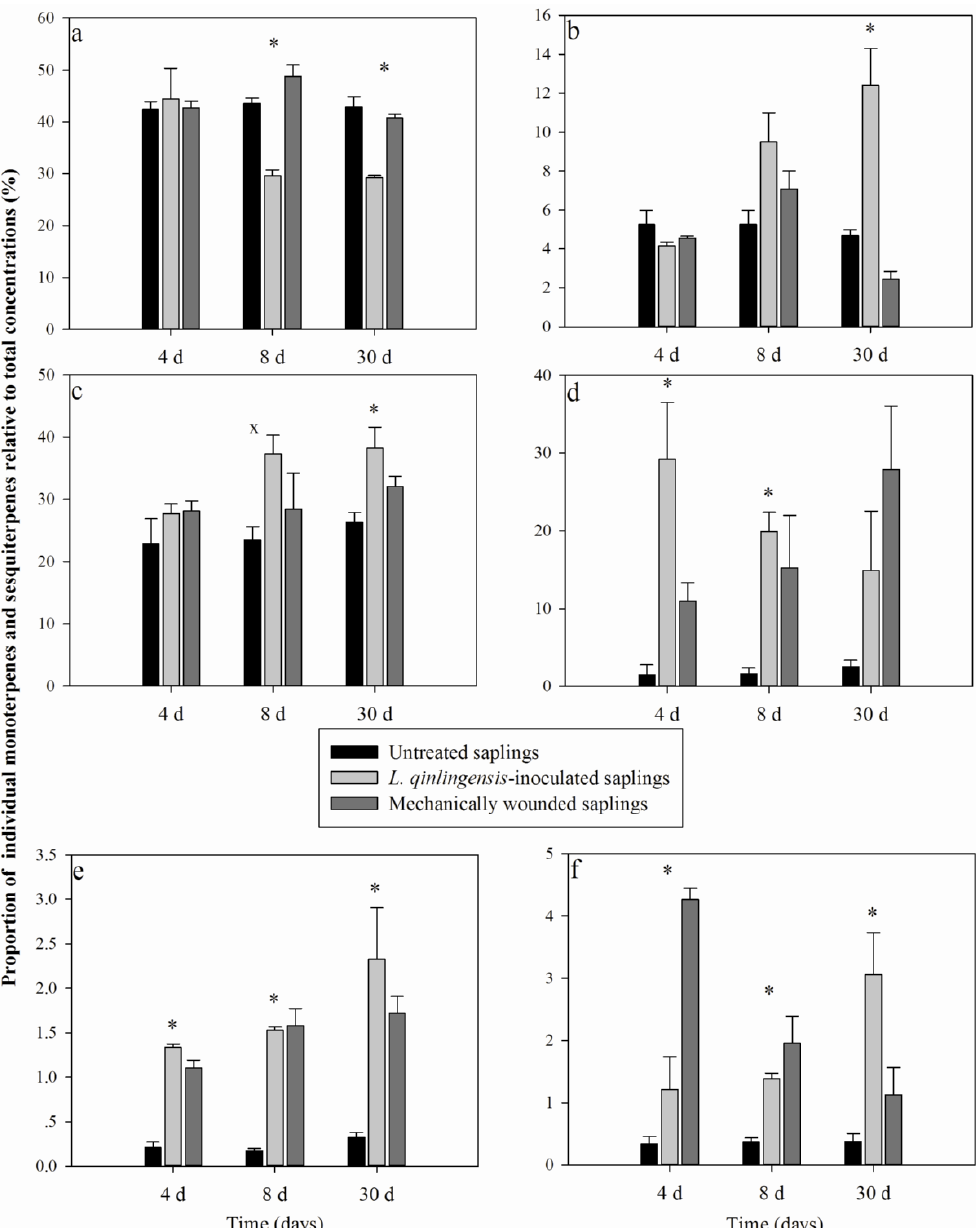
Figure 3. The proportional individual monoterpene and sesquiterpene concentrations (%) in the phloem of the stem of P. armandi saplings relative to total concentrations differ among treatments at each time point. a = α -pinene; b = β -pinene; c = limonene + β -phellandrene; d = longifolene; e = α -muurolene; f = δ -cadinene; * indicates that there was a significant difference ( p < 0.05) between treatments using ANOVA at each time point and x indicates that there was a significant difference ( p < 0.05) among L. qinlingensis -inoculated saplings and untreated saplings using ANOVA at each time point; Each bar represents the mean total ± standard error of three